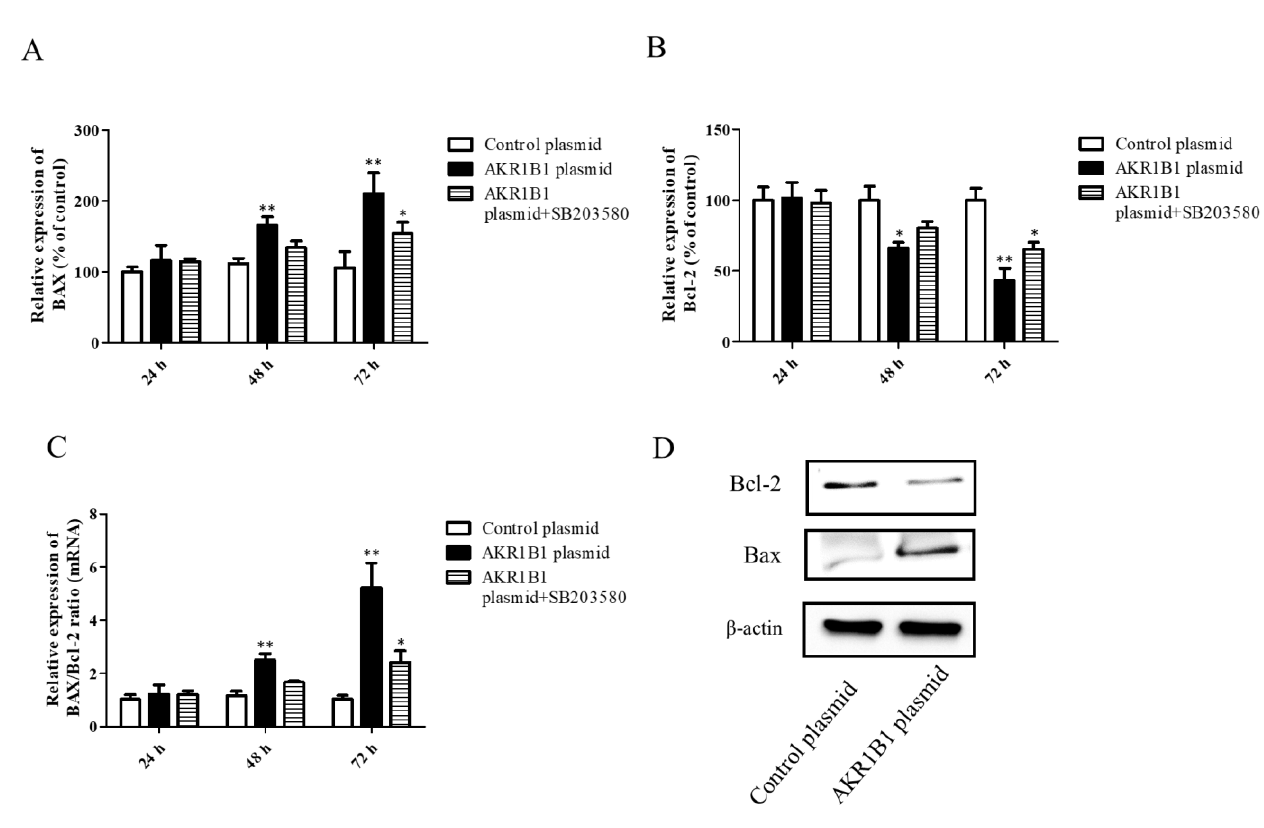
Figure 5. AKR1B1 induced cell apoptosis in human glioma cells. ( A – D ) The anti-apoptotic effect was evaluated by assessing the pro-apoptotic BAX signal, the antiapoptotic protein Bcl-2, and the BAX/Bcl-2 ratio in T98G cells with overexpressed AKR1B1. The mRNA levels of BAX ( A ) and Bcl-2 ( B ) in T98G cells transfected with the control, the AKR1B1 plasmid, or SB203580 were measured by quantitative reverse-transcription polymerase chain reaction at 24, 48, and 72 h after